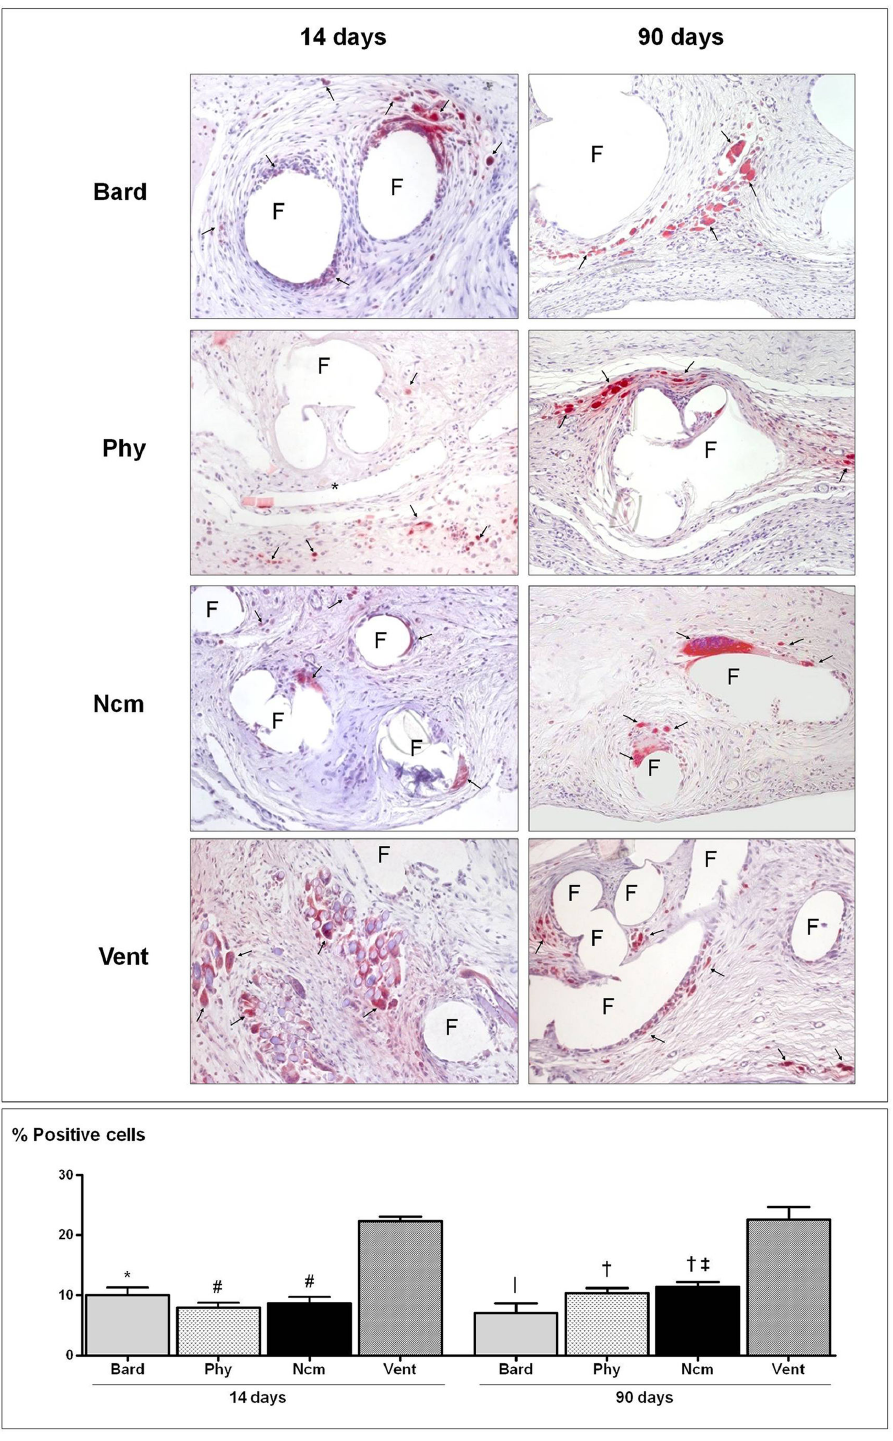
Figure 6. Foreign-body reaction of the different meshes. Immunohistochemical labelling of rabbit macrophages (arrows) using the RAM-11 monoclonal antibody (200x) (top panel). Positive cell percentages recorded after 14 and 90 days of implant (bottom panel). Results are expressed as the mean ± SEM. *, p<0.01 and #, p<0.001 vs. Ventralight TM at 14 days; |, p<0.01 and †, p<0.001 vs. Ventralight TM at 90 days; ‡, p<0.05 vs. Bard mesh TM at 90 days. Prosthetic filaments (F), polyglecaprone film (*). Physiomesh TM (Phy), new composite mesh (NCM), Ventralight TM (VL). doi: 10.1371/journal.pone.0080647.g006 PLOS ONE |